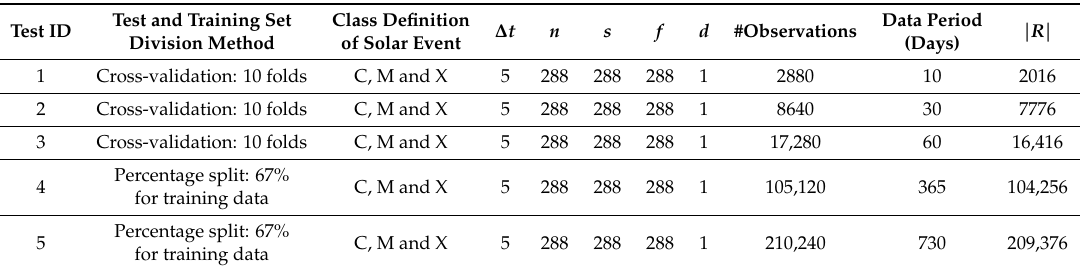
Table 5. Setup of the SeMiner experiments. Test ID is the number of the performed experiment; n (current window size), d (window step), s (jump) and f (size of the future window) are measured in numbers of observations; ∆ t (period of time) is measured in minutes; | R | is the number of generated